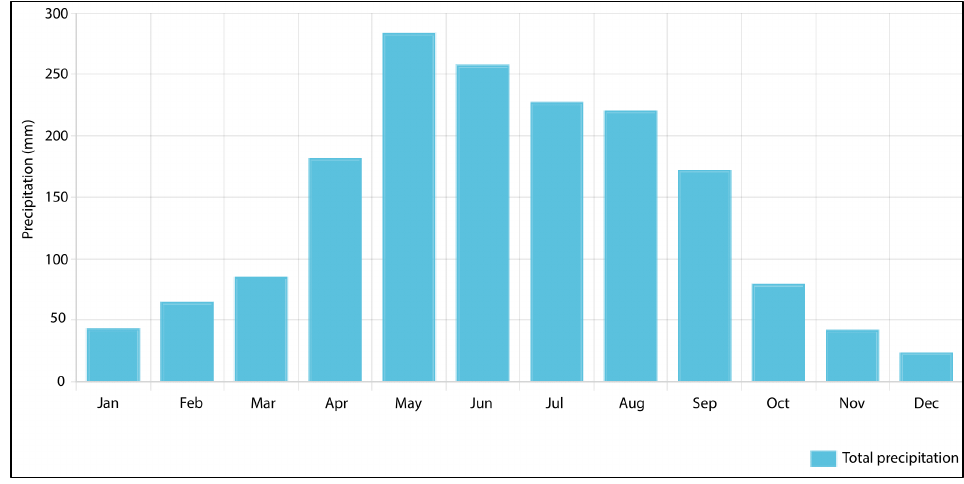
Figure 2. Monthly precipitation, 1961 – 1990.